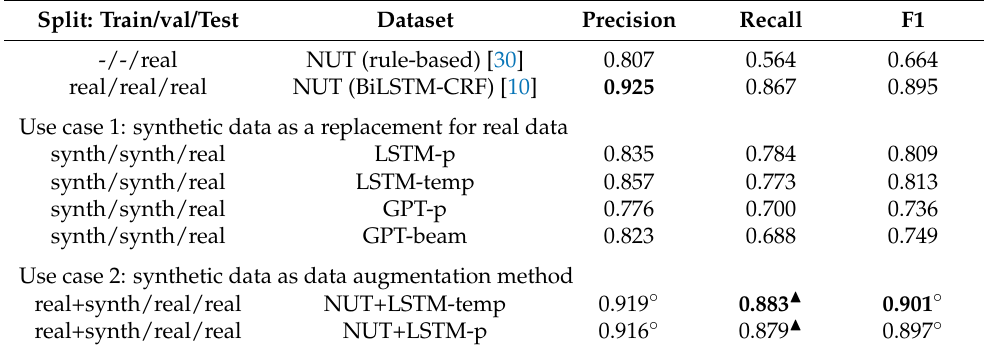
Table 6. Summary of downstream task performance. We train on the generated synthetic data and evaluate on real data with gold-standard annotations ( NUT dataset [10]). Statistically significant im- provements toward the NUT (BiLSTM-CRF) baseline are marked with difference. The test is a two-tailed approximate randomization ( p <